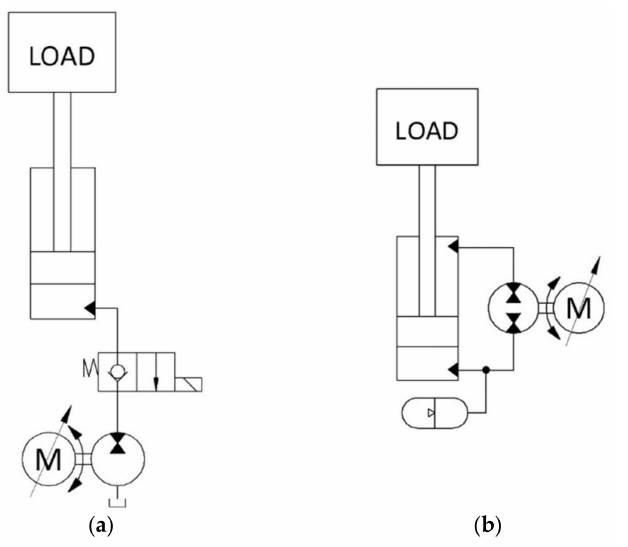
Figure 16. Frequency inverter (FI) application: ( a ) open circuit; ( b ) closed circuit. Hagen et al. [45] compared the use of electromechanical and electrohydraulic actuators in the motion control system of a single-boom crane. The study showed that the latter solution had 20% more continuous power capacity and 47% less installed electrical